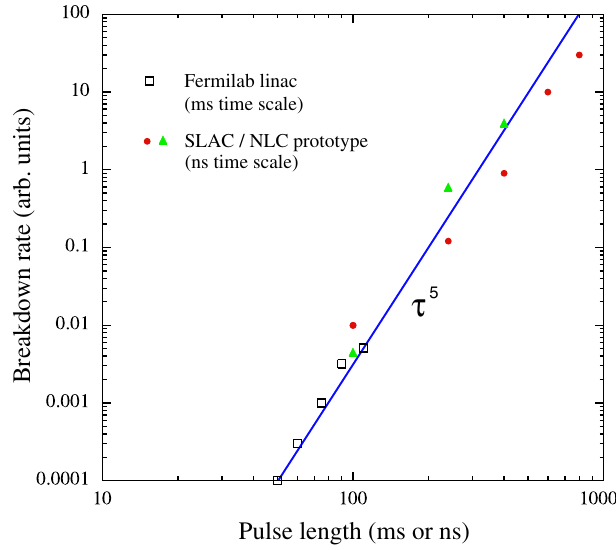
FIG. 13. (Color) Comparing breakdown rates as a function of pulse length for fixed electric field in the Fermilab linac (open squares) [37], and SLAC/NLC prototype (solid circles and triangles) [33], with estimates. The time scale for the Fermilab data is ms, and the SLAC data is ns. Both have a (cid:6) 5 dependence over widely different time